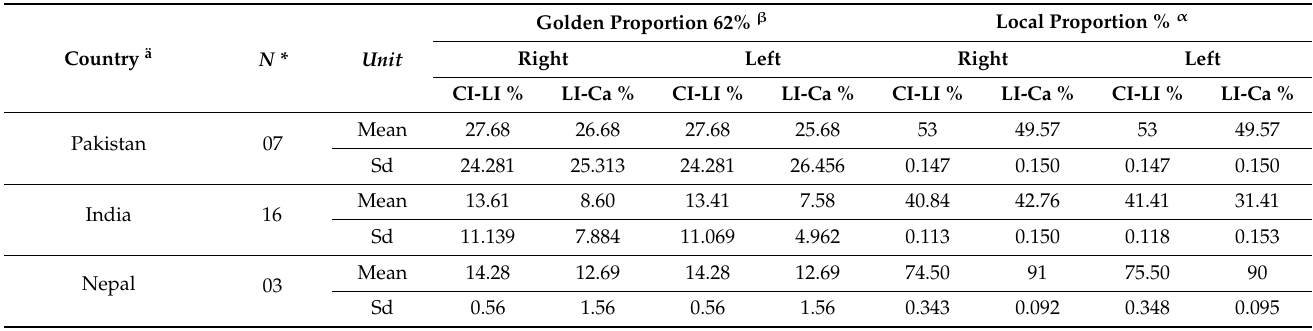
Table 3. Incidence of golden proportion among included studies based on the geographical regions ( n =